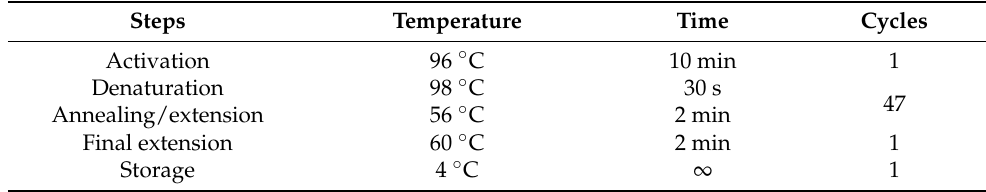
Table 10. Amplification conditions used in